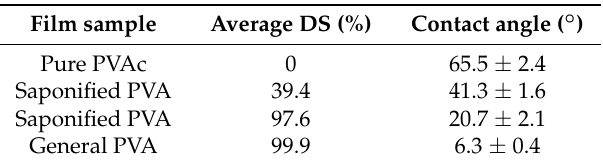
Table 2. Contact angles of the PVAc film, general PVA film, and saponified PVA film with respect to the